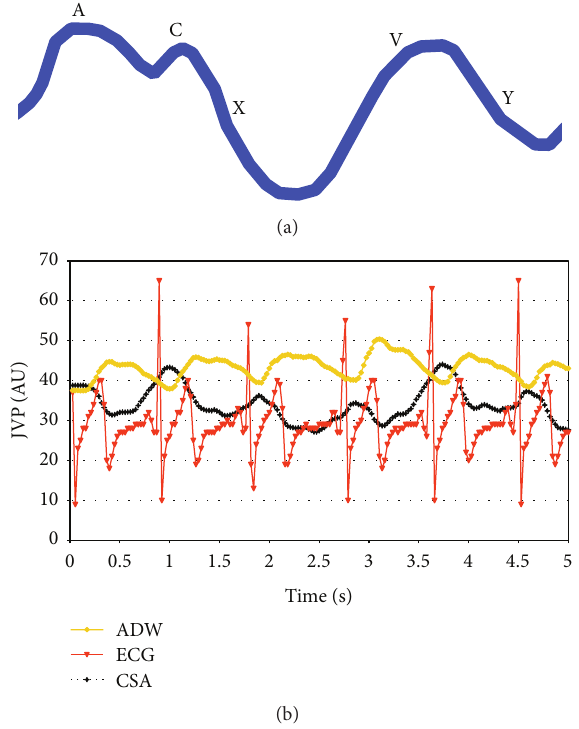
Figure 4: (a) The sequence of the 5 positive and negative waves composing the JVP, propagating the heart pressure upward the jugular vein. (b) Noninvasive ultrasonic assessment of JVP (black line) perfectly synchronized with the ECG trace (red line) and with the carotid artery distension wave (yellow line). The traces are derived by a high resolution B-mode video clip connected to an ECG. Their quantification allows a noninvasive assessment of the heart-brain